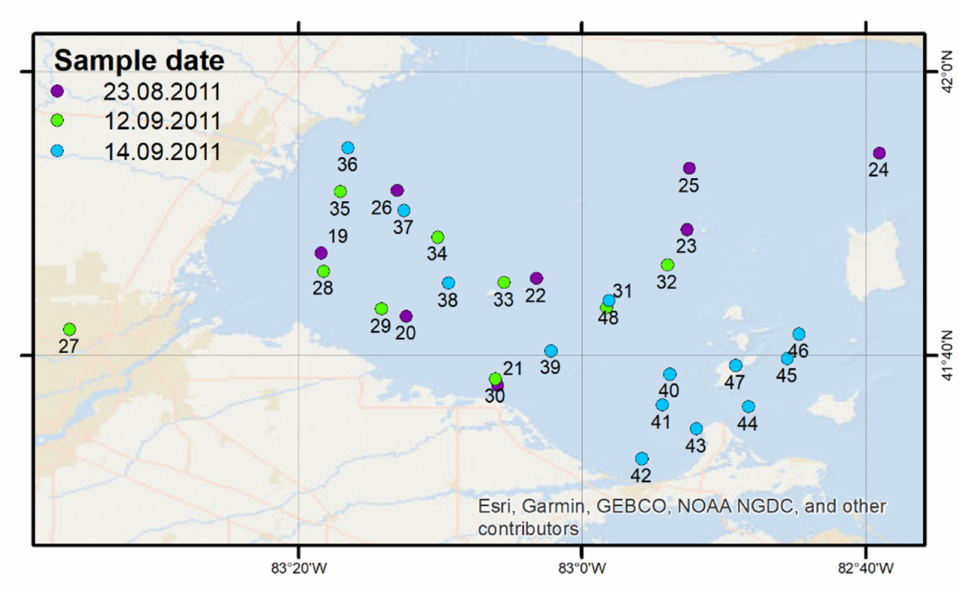
Figure 4. Distribution of sample sites. (Data source: CIGLR).